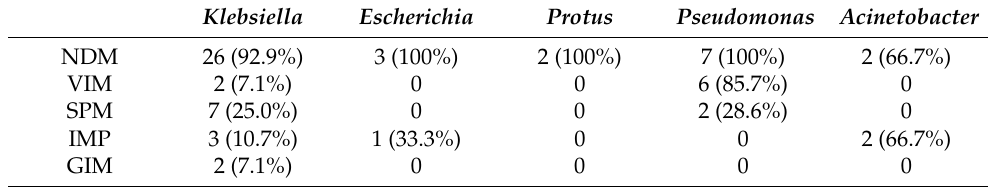
Table 5. Association between resistance genes and imipenem resistant strains (regarding mCIM).